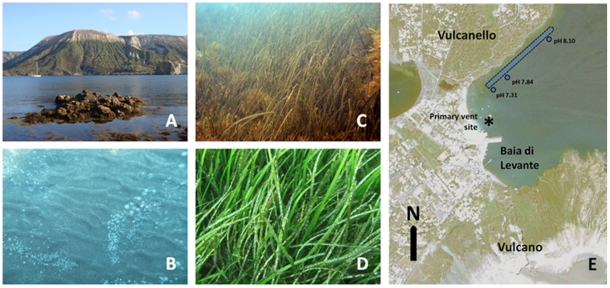
Location of the underwater CO2 vent and seagrass meadows on the Island of Vulcano, Italy.(A) Location of near shore transect beneath the volcano, where dense populations of Cymodocea nodosa inhabit shallow grass beds (C,D). (E) The sampling sites spanned a range of high CO2/low pH conditions at distances of 260, 300 and 380 m from the vent site (*) along the northern shoreline of the bay.